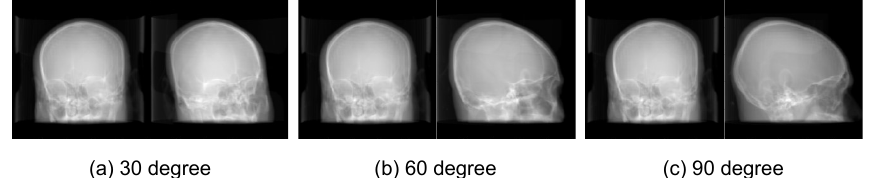
Figure 9. Examples of CT-DRR datasets in different projection angles.